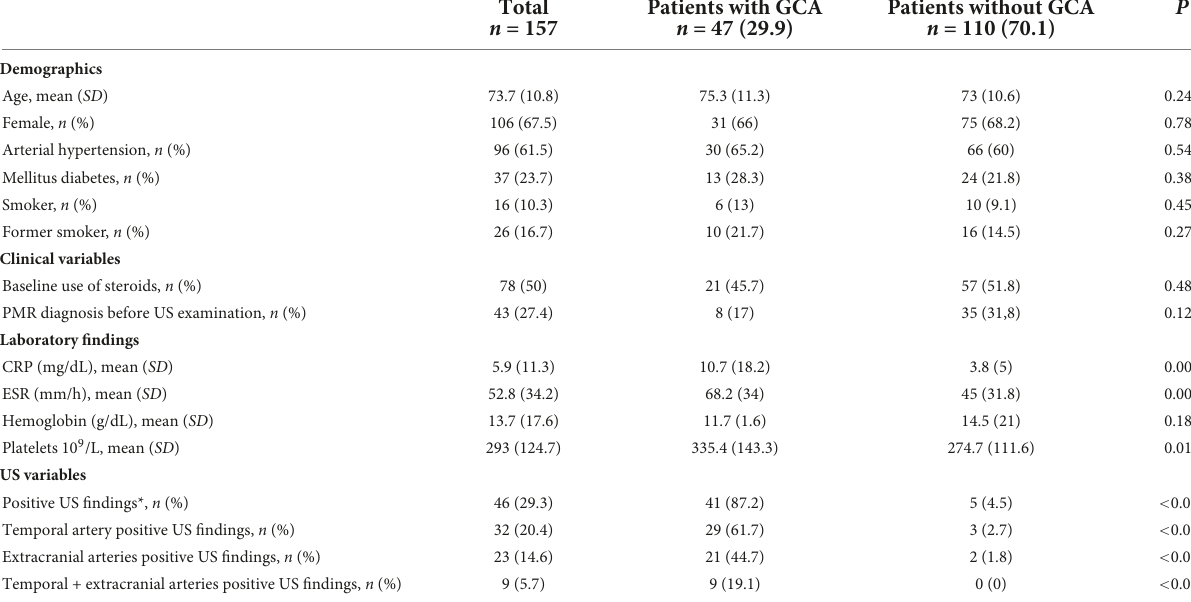
TABLE 1 Clinical, laboratory and US findings of patients with and without GCA.